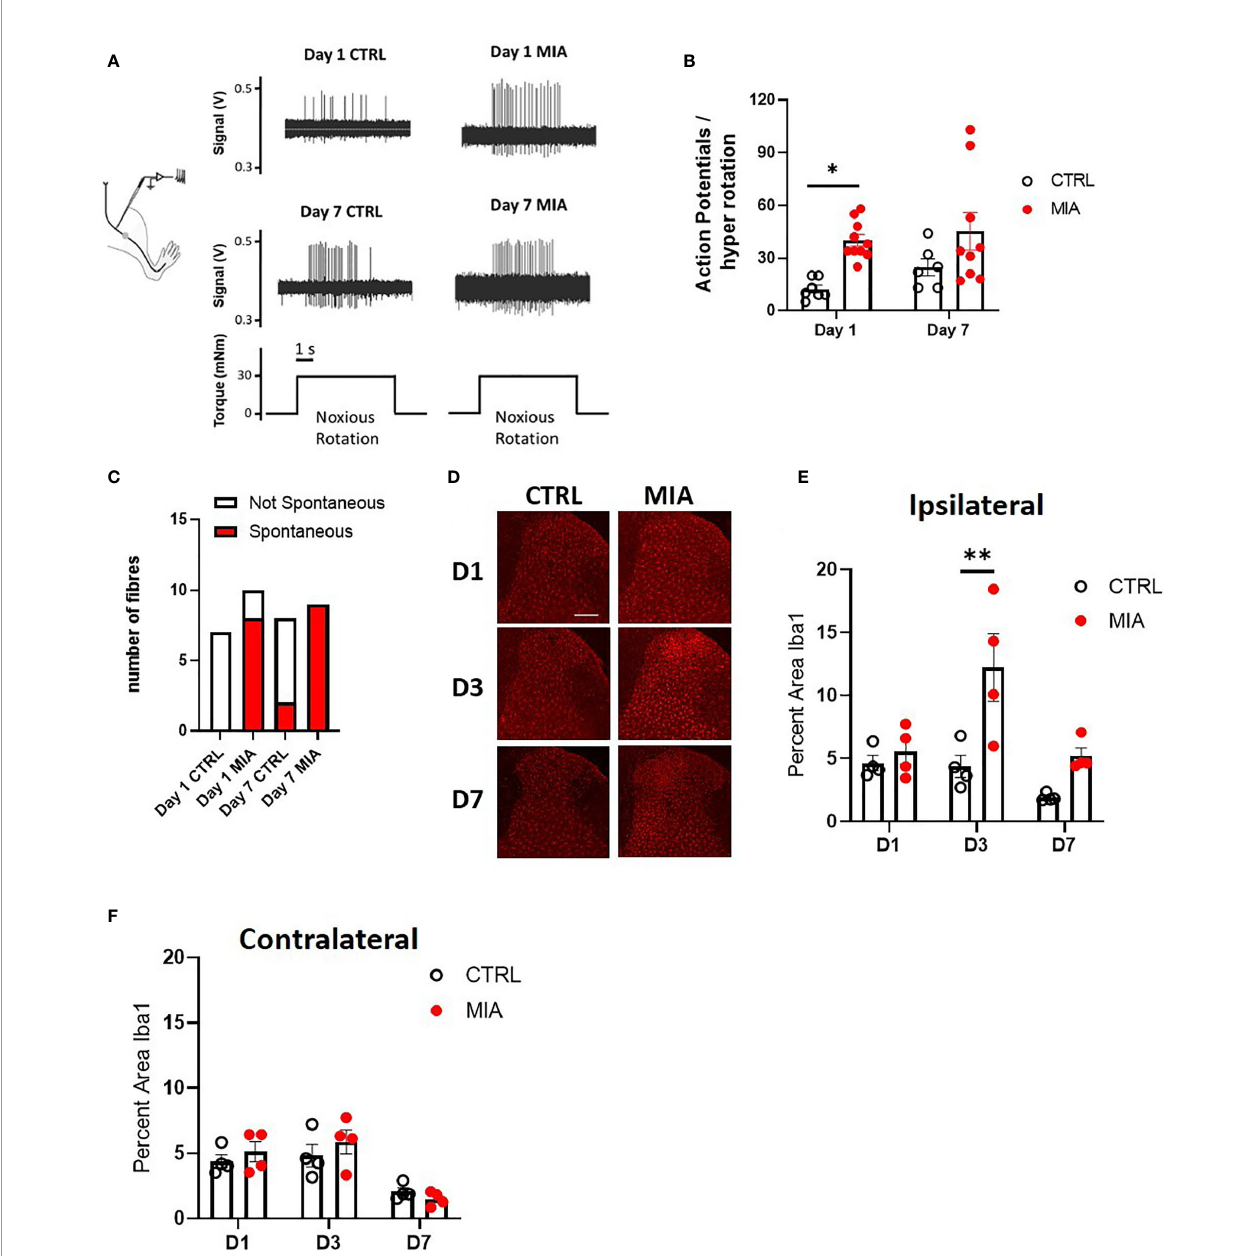
FIGURE 1 | Peripheral joint in fl ammation increases primary afferent activity and spinal microglial response in male rats. (A) Schematic diagram of joint afferent recordings in primary afferents after knee injections of MIA (80mg/ml, 25 m L) or saline (CTRL, 25 m L). (B) Primary afferent activity at days 1 and 7 after MIA injections (N=6 to 9 animals per group). (C) Spontaneous fi ring at days 1 and 7 after MIA injections (N=6 to 9 animals per group). (D) Representative images of Iba1 immunoreactivity, a measure of microglial responses after MIA injections. Scale bar = 200 m m. (E) Quanti fi cation of Iba1 immunoreactivity in the ipsilateral spinal dorsal horn at days 1, 3 and 7 after MIA injections (N=4 animals per group). (F) Quanti fi cation of Iba1 immunoreactivity in the contralateral dorsal horn at days 1, 3 and 7 after MIA injections (N=4 animals per group). *P < 0.05, **P < 0.01 comparisons between control and MIA